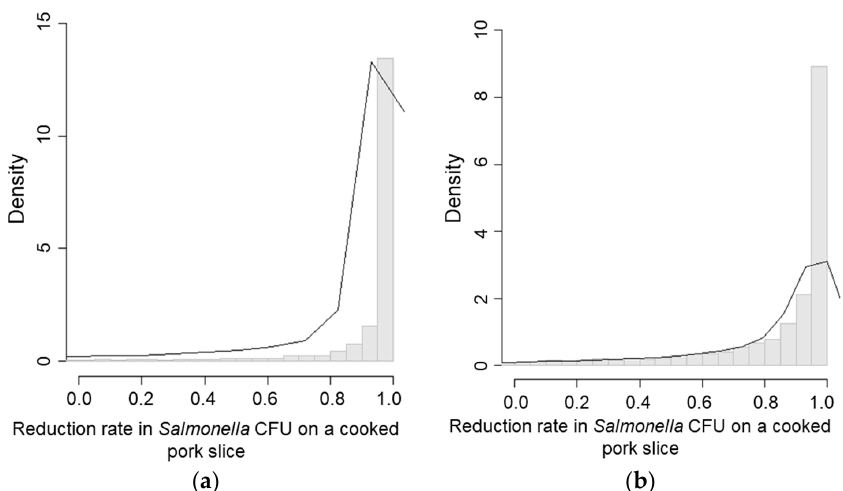
Figure 7. Reduction rate in CFU/g on a cooked pork slide in worst case scenarios. ( a ) Scenario 1—